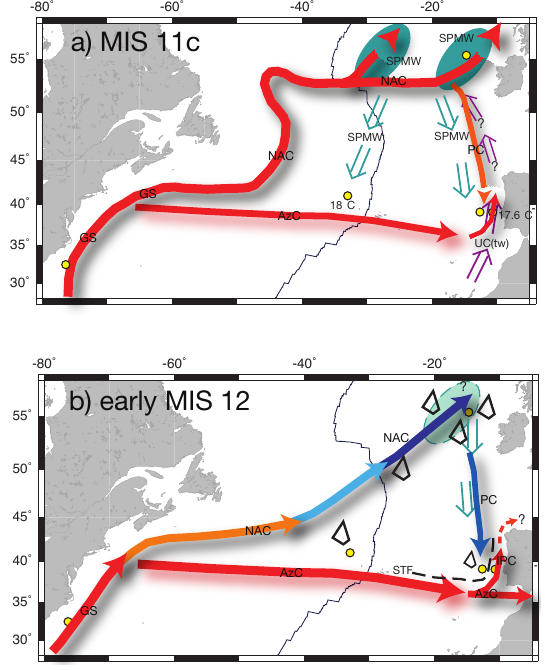
Fig. 9. Circulation schemes for interglacial MIS 11c (a) and early glacial MIS 12 (b) arising from this study. Abbreviations for cur- rents are the same as in Fig. 1. Open arrows show subsurface flows. UC(tw) indicates undercurrent transporting tropical waters and SPMW subpolar mode waters formed in the regions desig- nated by ellipses of the same color. SST values listed in (a) give means for the interval from 425 to 396ka for the alkenone tem- peratures measured at IODP Site U1313 and in core MD03-2699. Dashed line in (b) indicates (winter-time) hydrographic front sepa- rating sites MD01-2446 and MD03-2699, here denoted as subtropi- cal front (STF). Black “diamonds” indicate presence of melting ice- bergs based on IRD data and include evidence from core M23414 (Kandiano and Bauch, 2003) and from IODP Site U1308 (Hodell et al., 2008).